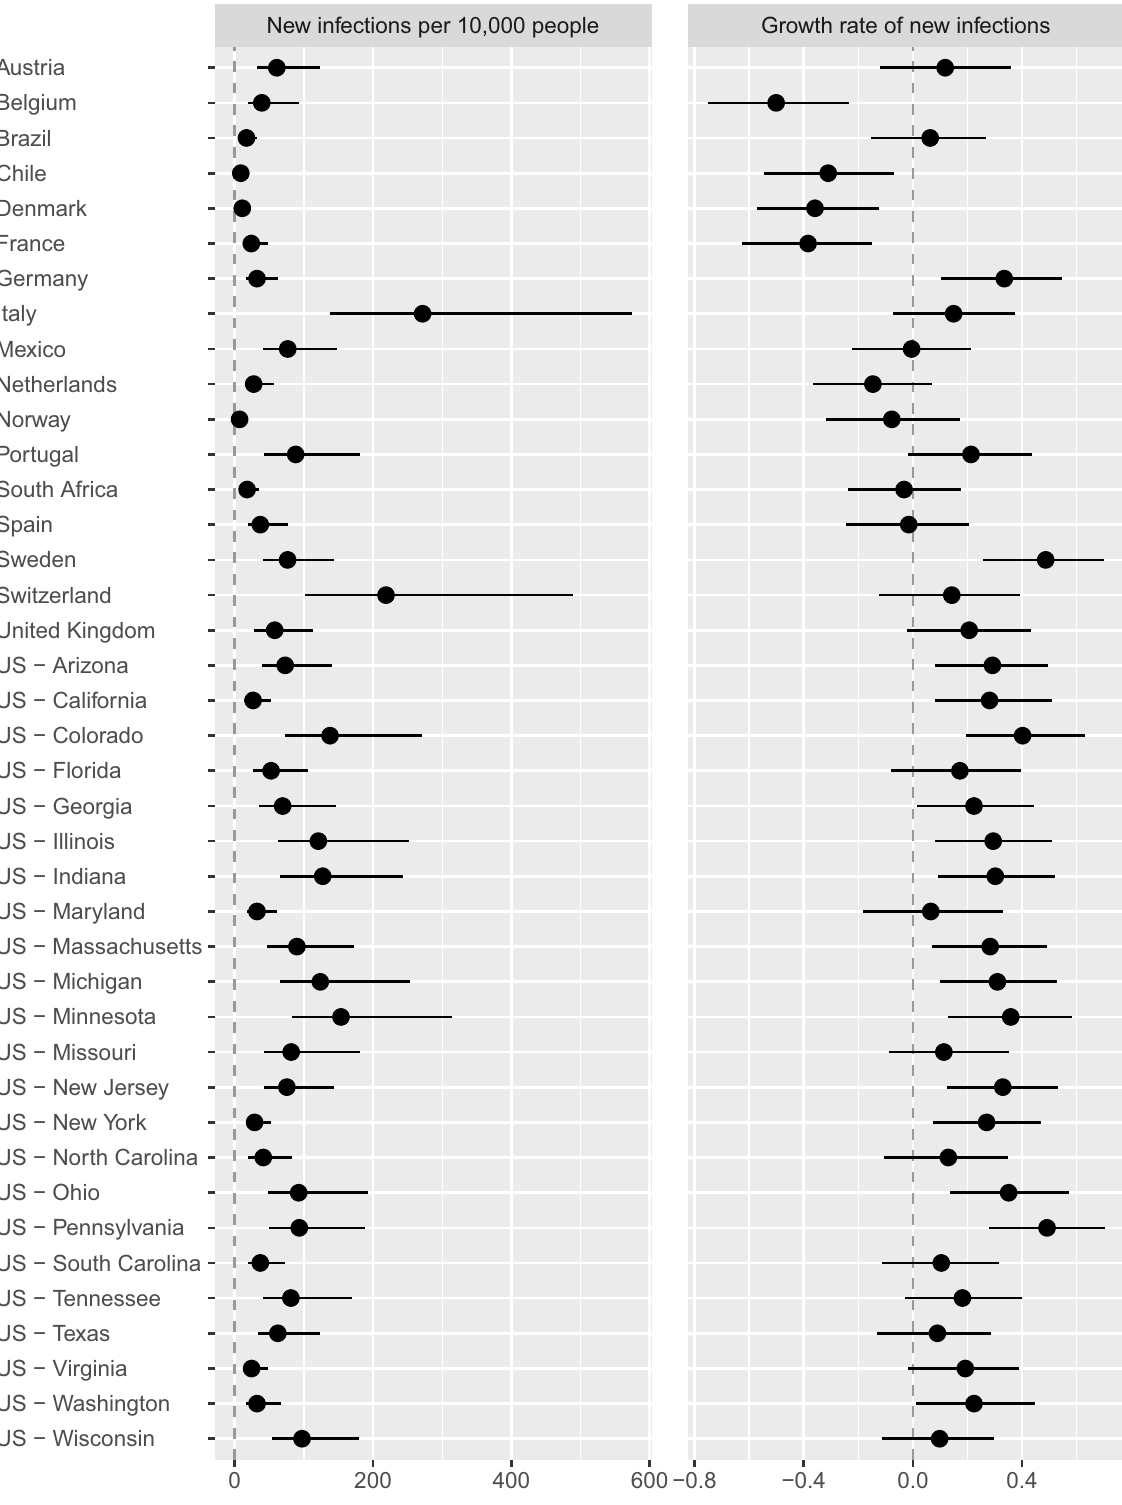
PLOS ONE | https://doi.org/10.1371/journal.pone.0244177 December29,